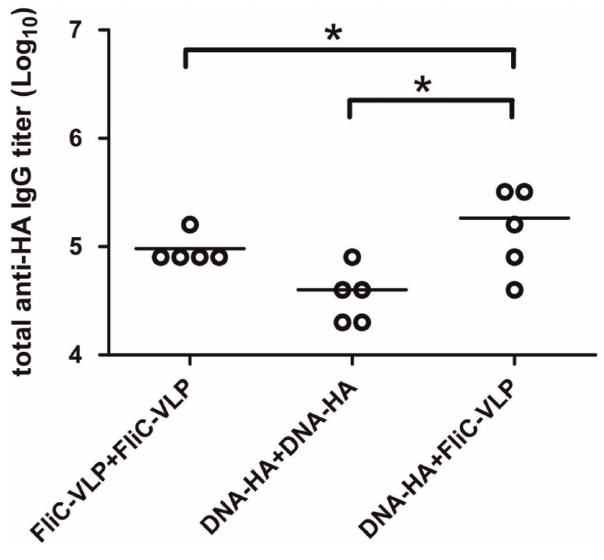
Figure 1. Total anti-HA IgG titers elicited by DNA-HA and FliC- VLPs. BALB/c mice were immunized using a prime boost regimen over a three-week interval as shown: (i) FliC-VLP + FliC-VLP, (ii) DNA-HA + DNA- HA, or (iii) DNA-HA + FliC-VLP. Sera were collected two weeks following the booster immunization. Results indicate significantly higher HA- specific IgG titers from DNA-HA vaccine vector priming followed by FliC-VLP boosting. Shown are individual titers (points) and geometric means (lines) for each group. Asterisks (*) indicate statistical significance at p , 0.05.